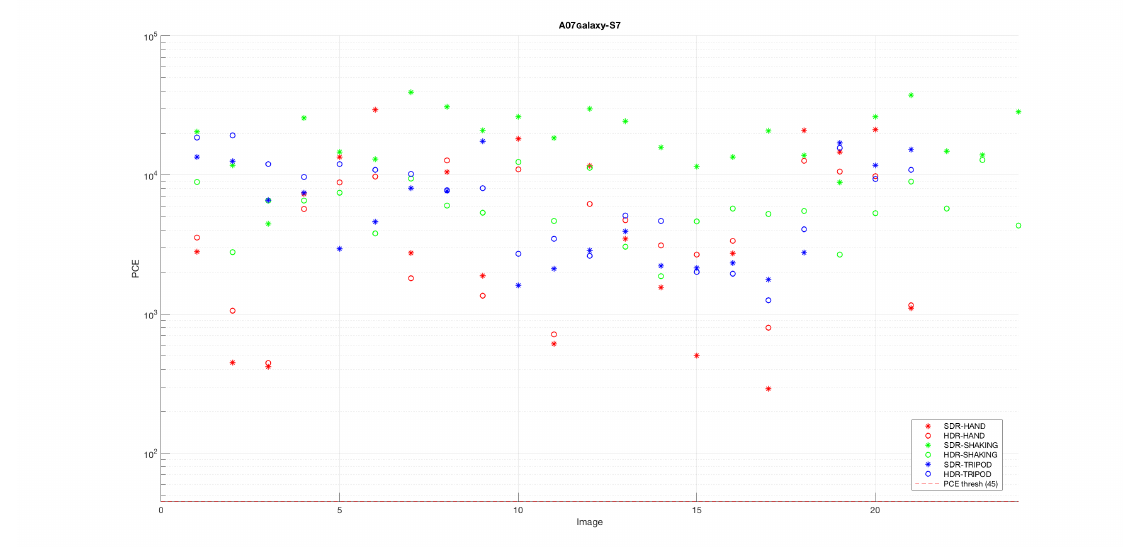
Figure 8. Example of the result obtained when correlating noise from SDR images captured by the A07 model with the HDR image fingerprint. A,